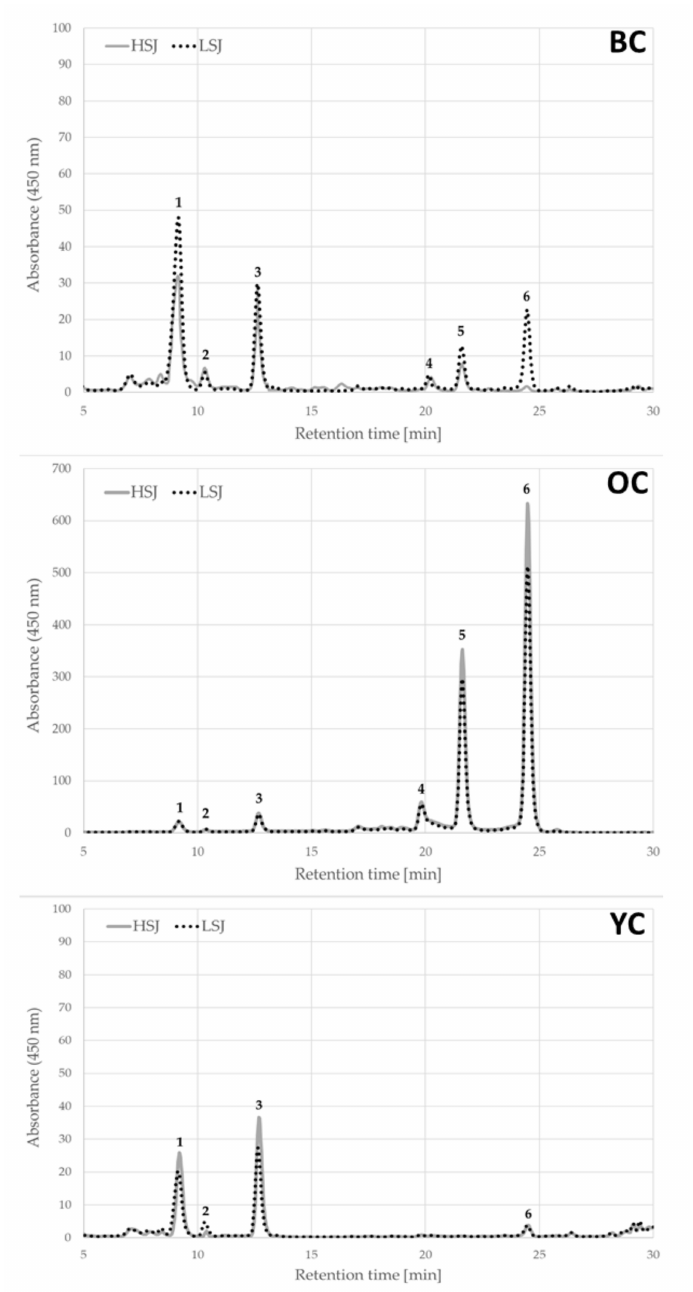
Figure 1. The high performance liquid chromatography (HPLC) chromatograms of carotenoid compounds identified in the carrot juices. Identified peaks are as follows: 1—lutein, 2—zeaxantin, 3— β -apo-8 (cid:48) carotenal (used as an internal standard), 4—13- cis - β -carotene, 5— α -carotene and 6— β -carotene.